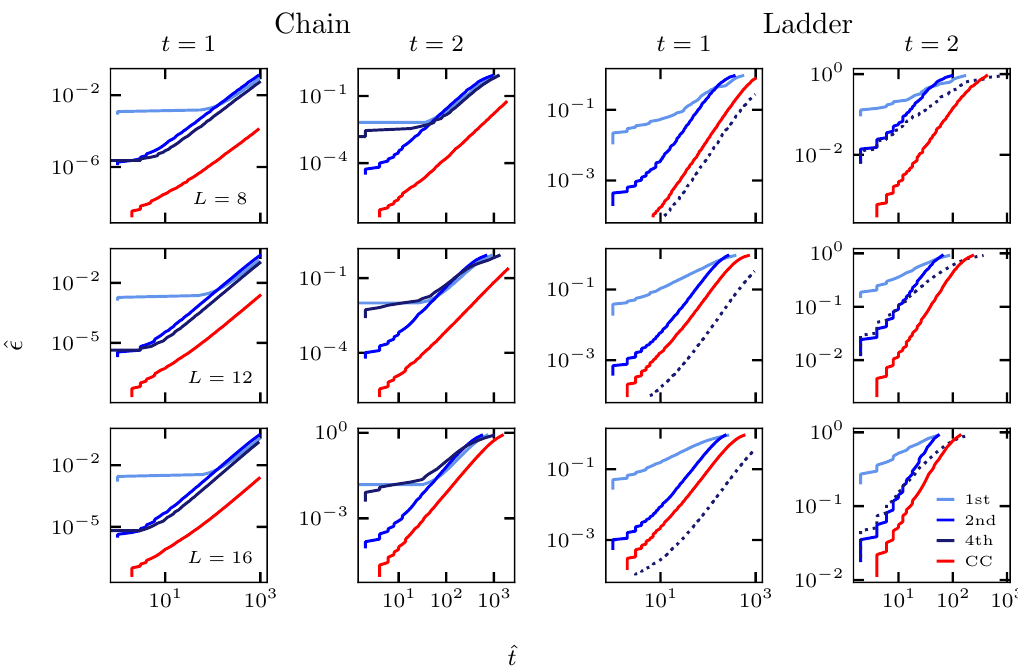
Figure 5: The time ˆ t after which the stacked circuits exceed the infidelity threshold ˆ ε , for the time evolution operator of the Heisenberg model on a chain (left panels) and ladder (right panels) in log-log scale. The first and third columns are for circuits optimized at t = 1 while the second and fourth columns are for t = 2, with the circuits being stacked up to a thousand times. The circuits were chosen such that they have similar gate counts, with M = 8,8,7,1 for the chain and M = 16,4,3,1 for the ladder, for the compressed circuit and first-, second- and fourth-order Trotter circuits, respectively. The top panels are for L = 8 with χ = 256, the middle panels are for L = 12 with χ = 150, and the bottom panels are for L = 16 with χ = 100. The blue curves represent the Trotter circuits and the red curve represents the compressed circuit (CC). The fourth-order Trotter circuit for the ladder is displayed as a dashed line, since it contains roughly twice as many gates as the compressed circuit and is therefore not necessarily indicative of their relative